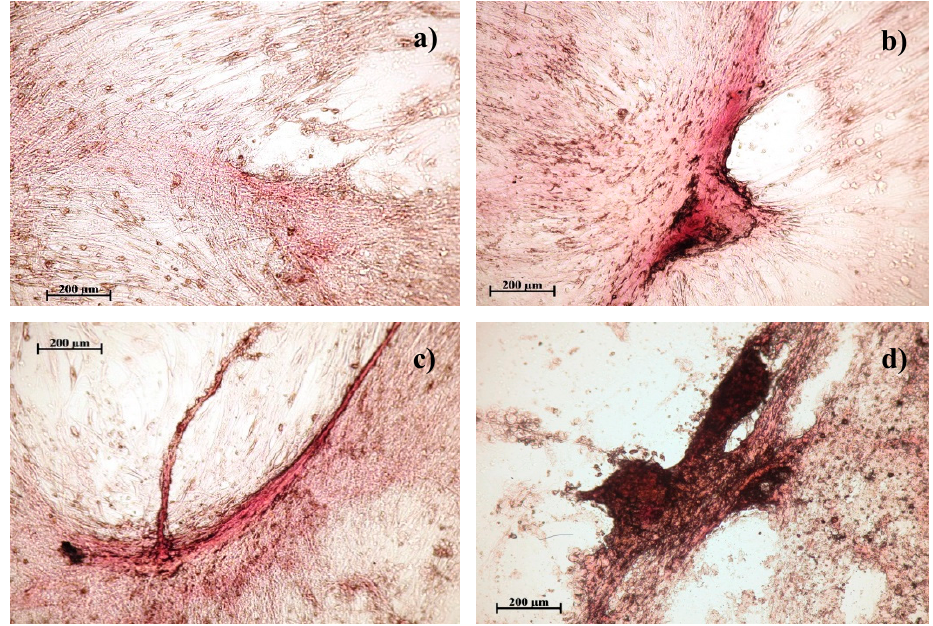
Figure 2. Culture of human multipotent mesenchymal stem cells after 21 days of cultivation in a standard nutrient medium: a—control; b—with the addition of 50 mg / L of chelidonic acid; c—with the addition of 50 mg / L of n-monobutyl ester of chelidonic acid; d—with the addition of 50 mg / L of chelidonic acid complex with calcium. Staining with alizarin red. Table 1. The indices of human adipose-derived multipotent mesenchymal stromal cell (hAMMSC) viability after 21 days of culturing in the presence of tested compounds, X ± standard deviation